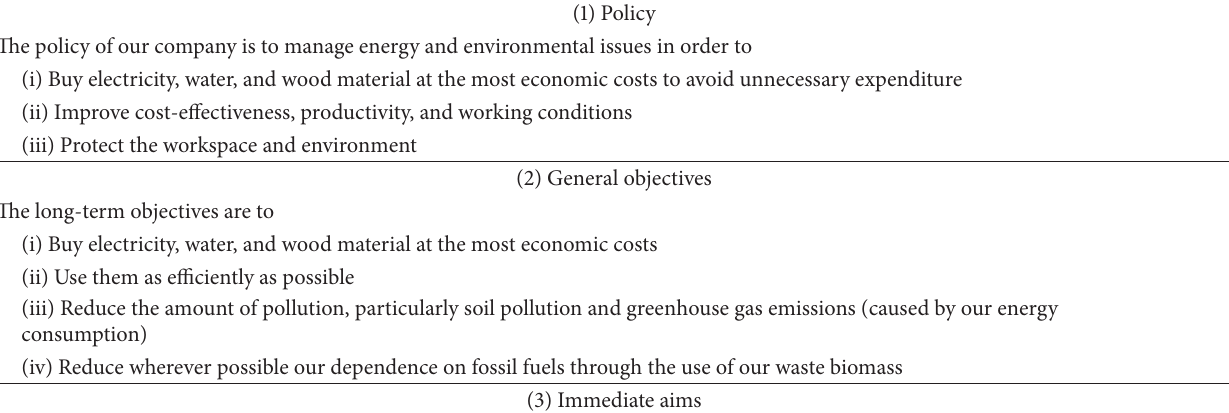
Table 3: Energy and environmental policy in XY company (wood furniture